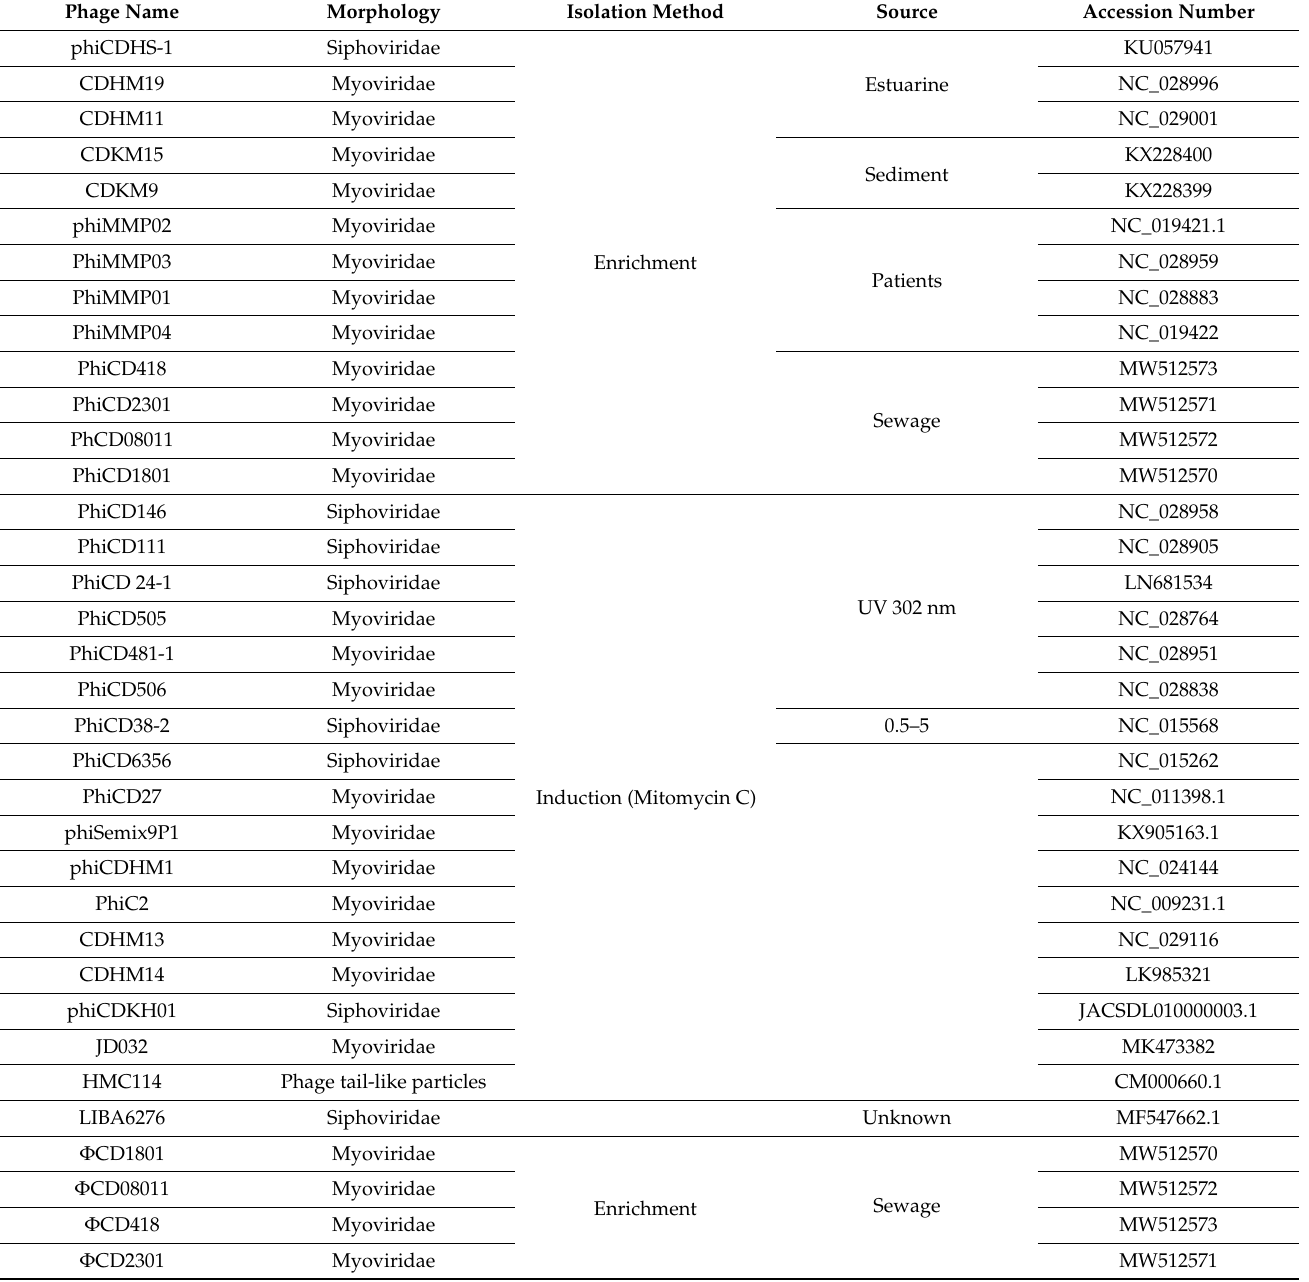
Table 1. List of fully characterised, publicly available C. difficile phage genomes, their sources and methods of